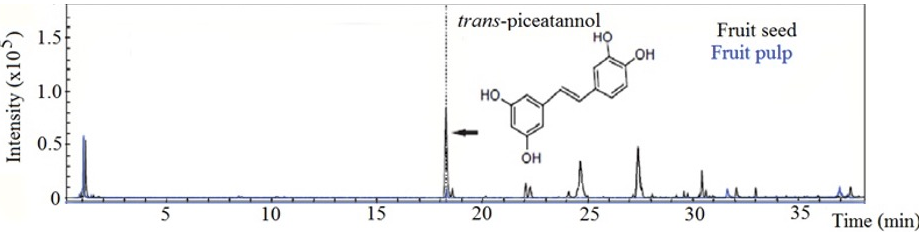
Figure 4. Chromatography profile of Byrsonima cydoniifolia seed and pulp extracts.